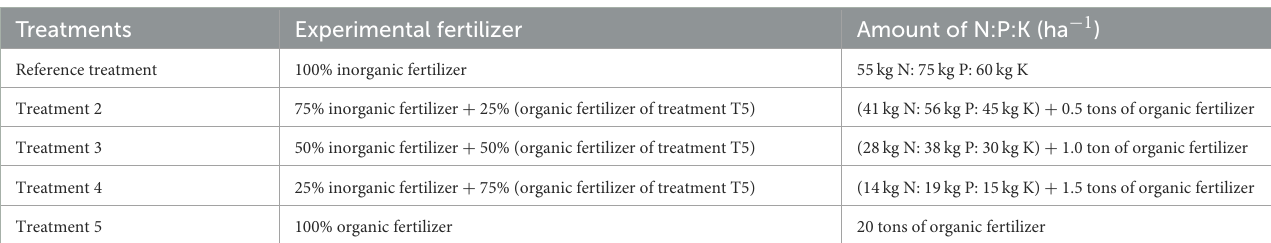
TABLE 1 Proportion of inorganic and organic fertilizers used for Malabar spinach ( Basella alba L.) and Amaranthus cruentus ( Amaranthus L.) vegetables